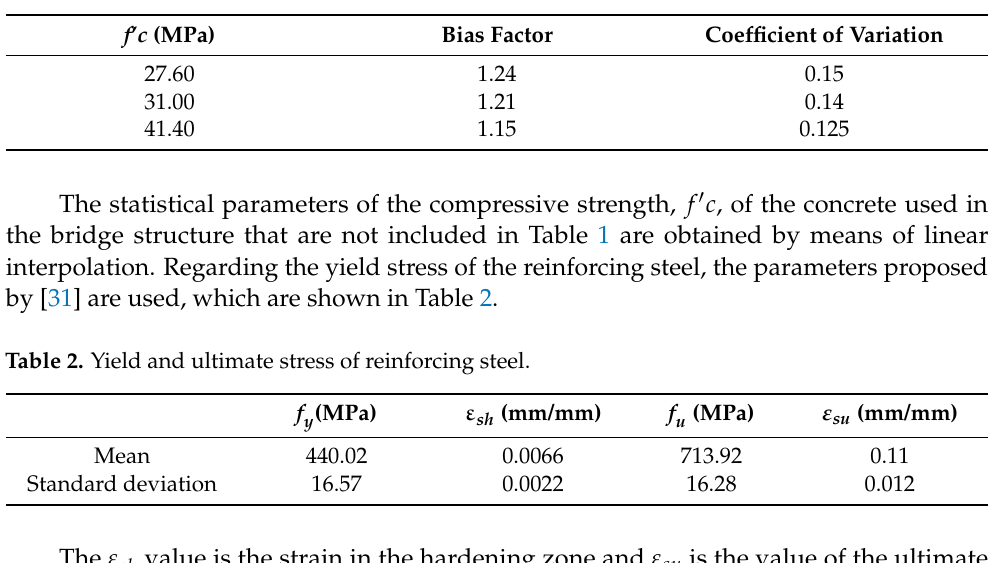
Table 1. Compressive stress, f (cid:48) c , of ordinary concrete.